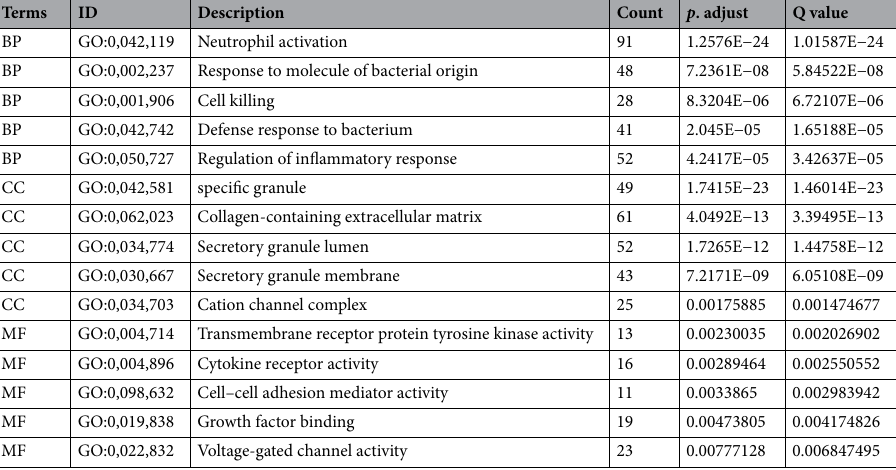
Table 2. Go enrichment of